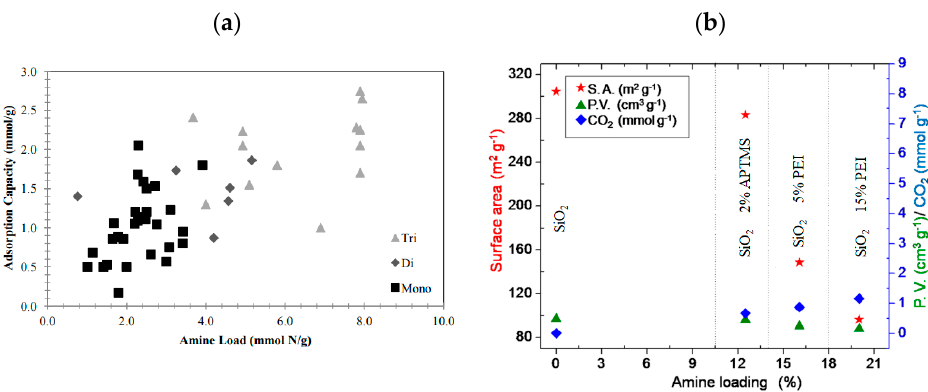
Figure 6. ( a ) Adsorption capacity of Mono, Di, and Tri-amine of PEI Impregnated Silica supports (all these sorbents were prepared and examined under similar conditions) [36]. ( b ) Surface properties and CO 2 adsorption as a function of amine loading [48].